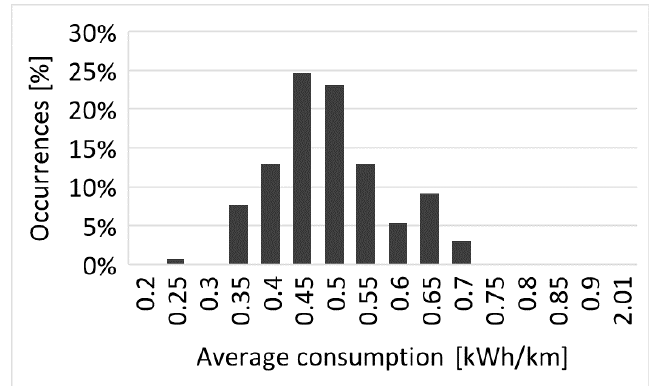
Figure 5. Occurrences of average consumption for different stretches.